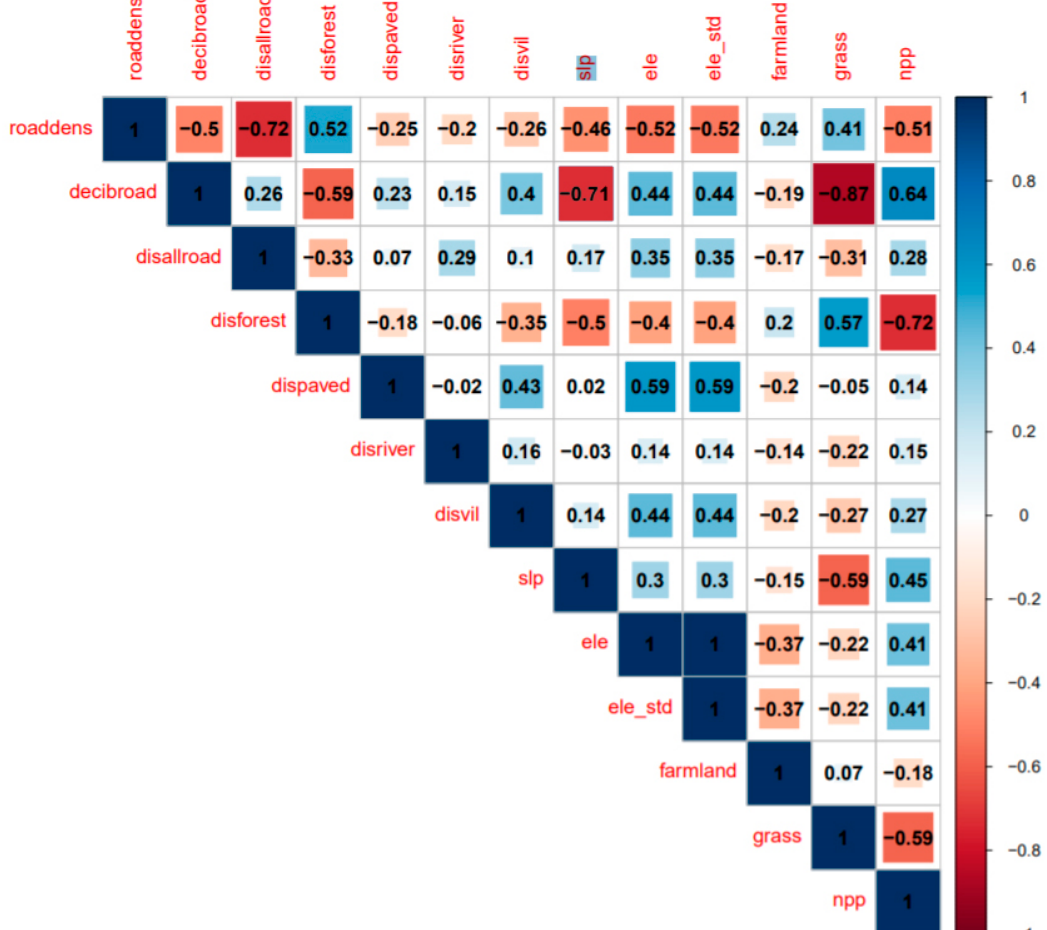
Figure 1. The correlation coe ffi cient matrix between the variables of the optimized scale.